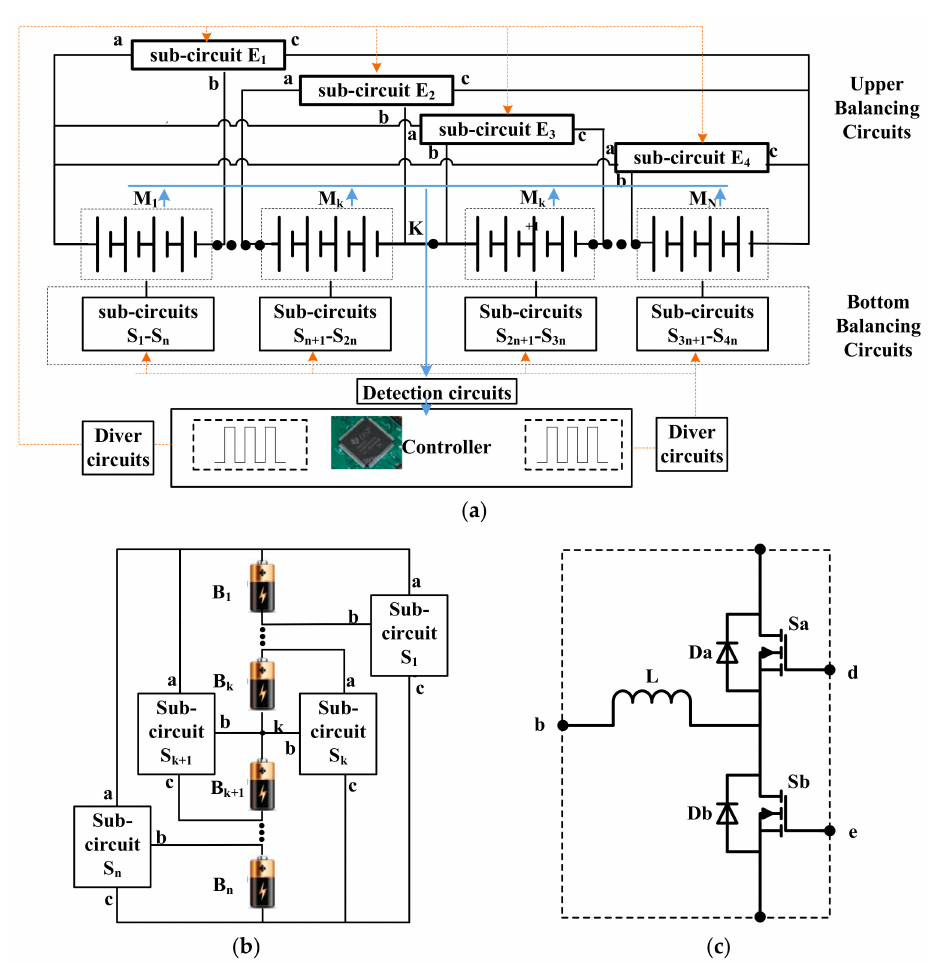
Figure 2. System configuration of the proposed equalizer ( a ) structure of the proposed equalizer; ( b ) schematic diagram of bottom balancing circuit; and ( c ) schematic diagram of balancing